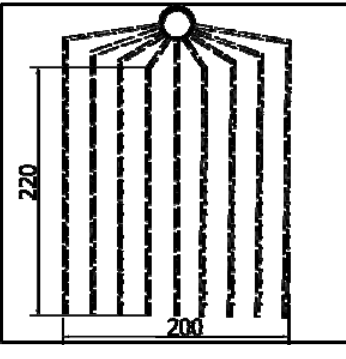
Fig. 2. The active zone of the droplet generator 200 x 200 mm .